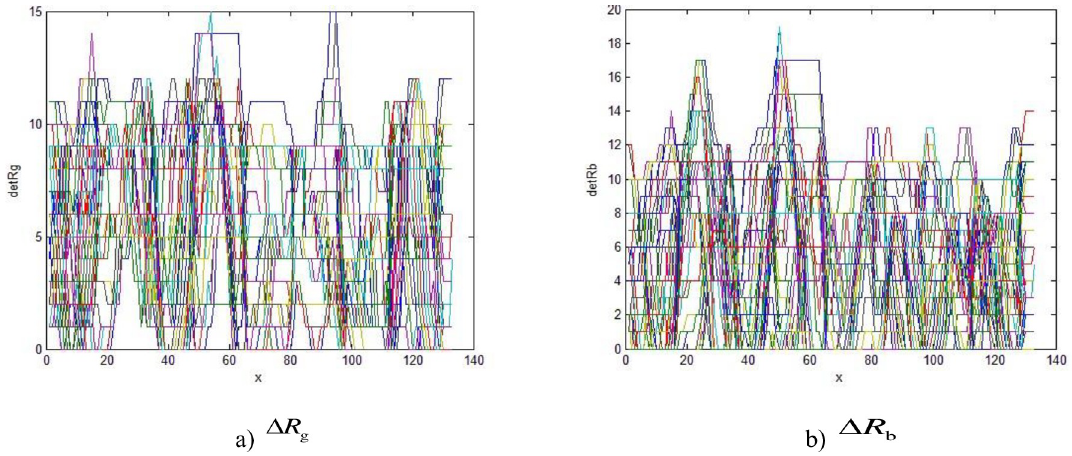
Fig 4. Other color area